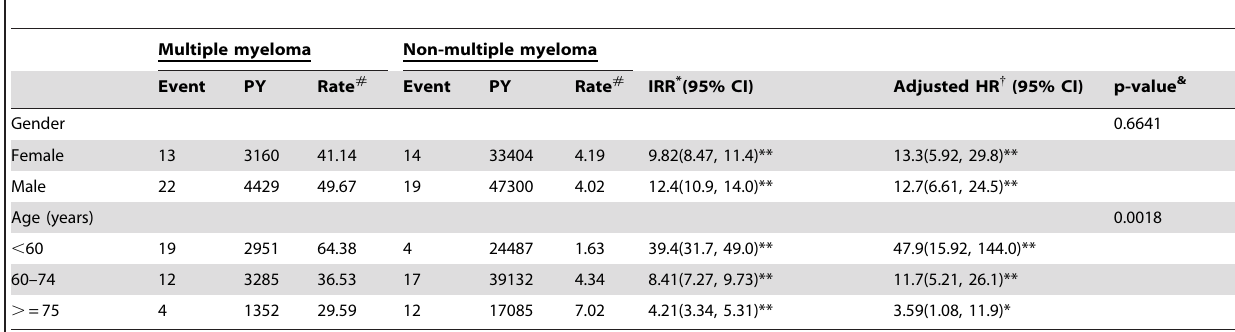
Table 3. Gender-and age-specific incidence, incidence rate ratio and adjusted hazard ratio of hematologic malignancy by gender and age between cohorts with and without multiple